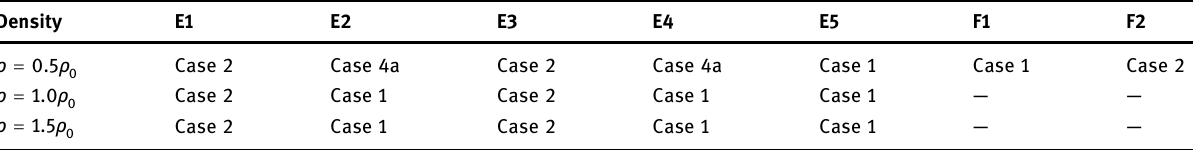
Table 7: Equilibrium points topological cases around Minerva at di ff erent densities Density